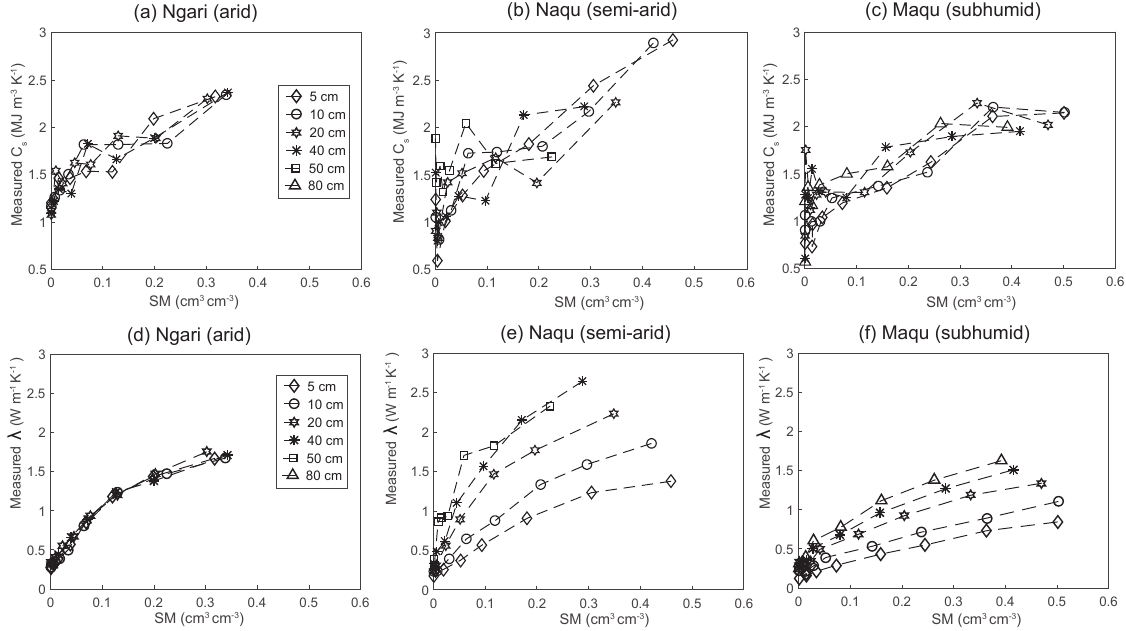
Figure 8. Mean soil heat capacity ( C s ) and thermal conductivities ( λ ) with varying water content (SM) at different depths in three climate